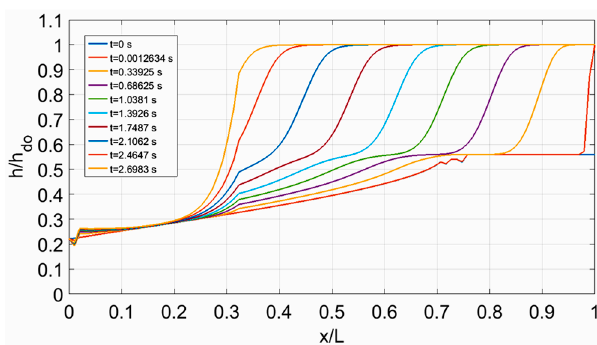
scheme including the Boussinesq terms.